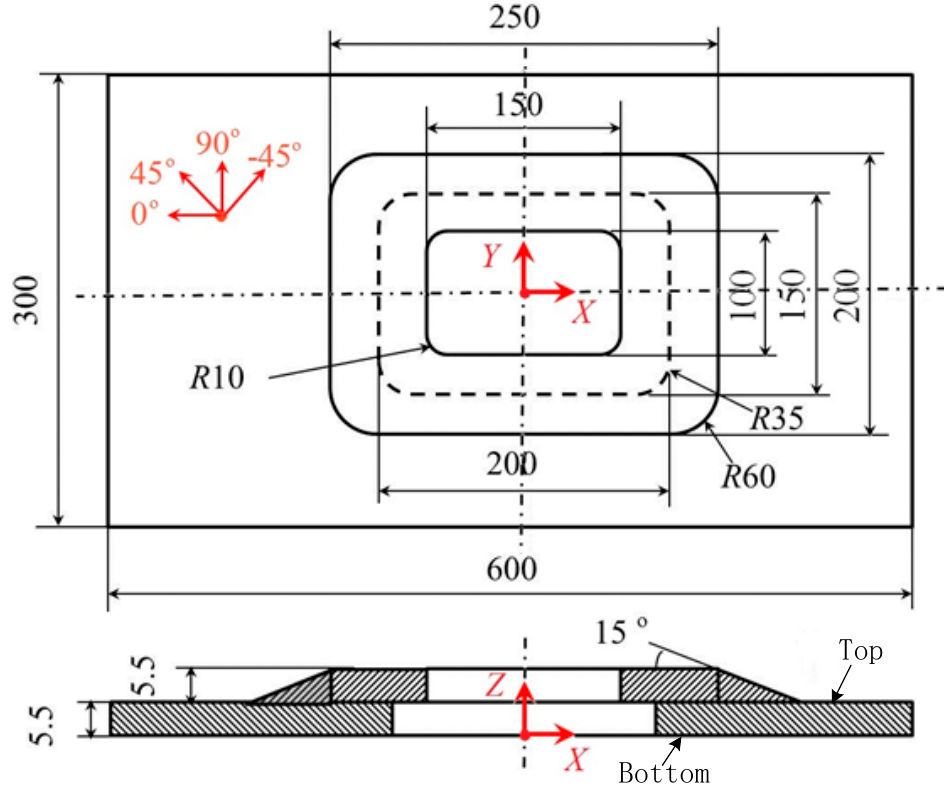
Figure 1. Geometrical model (All length units is mm).